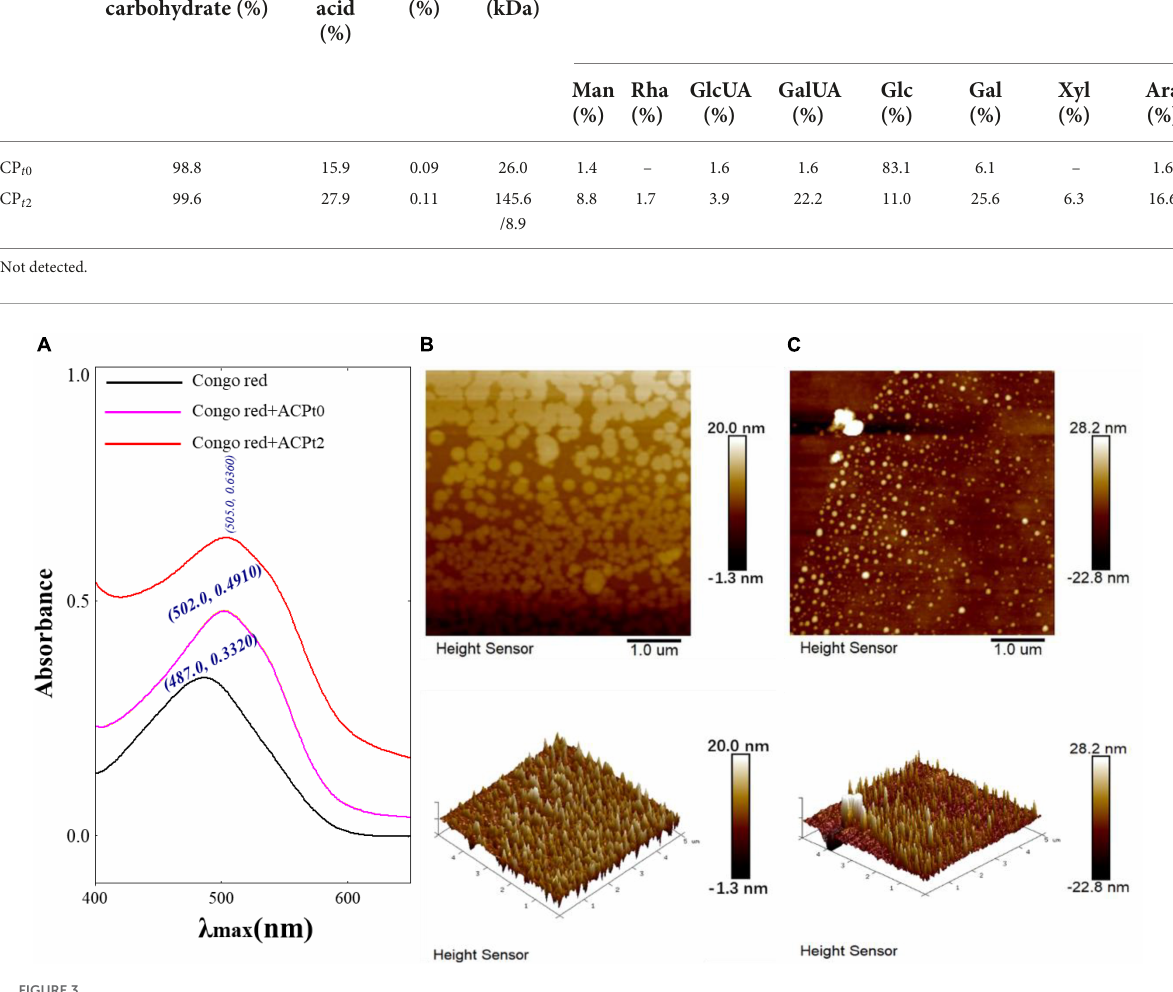
protrusions with heights between -22.80 and 28.20 nm were discovered on the surface of ACP t 0 and ACP t 2 . The surface height of ACP t 0 is slightly greater than ACP t 2 . It indicated that the biological activity of polysaccharides was related to the diameter and surface height of spherical particles focused in aqueous